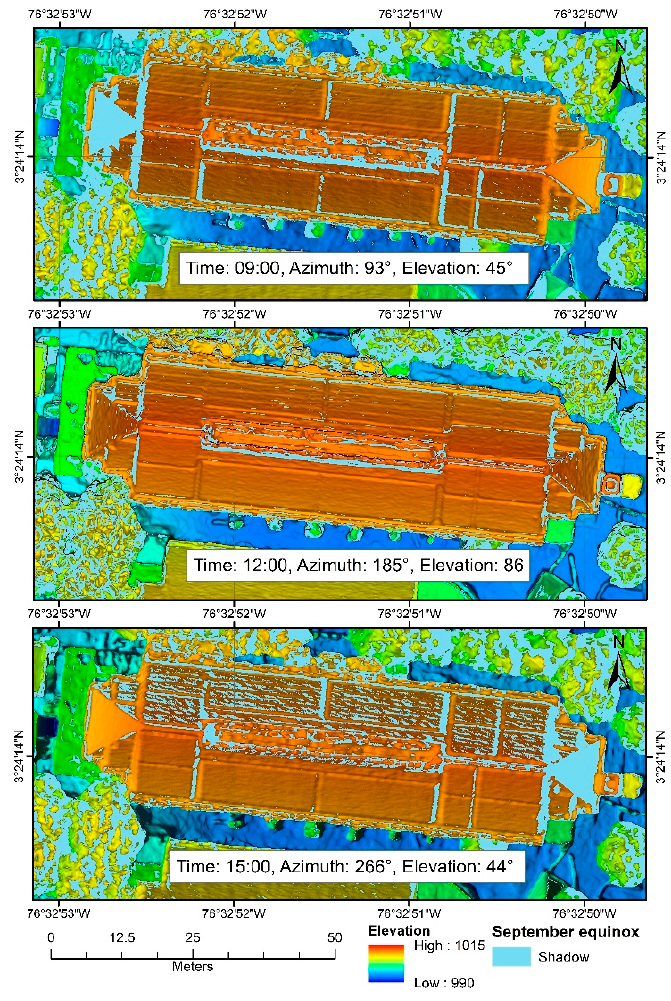
Figure 9. Shading on the DSM during equinox of September 2019.